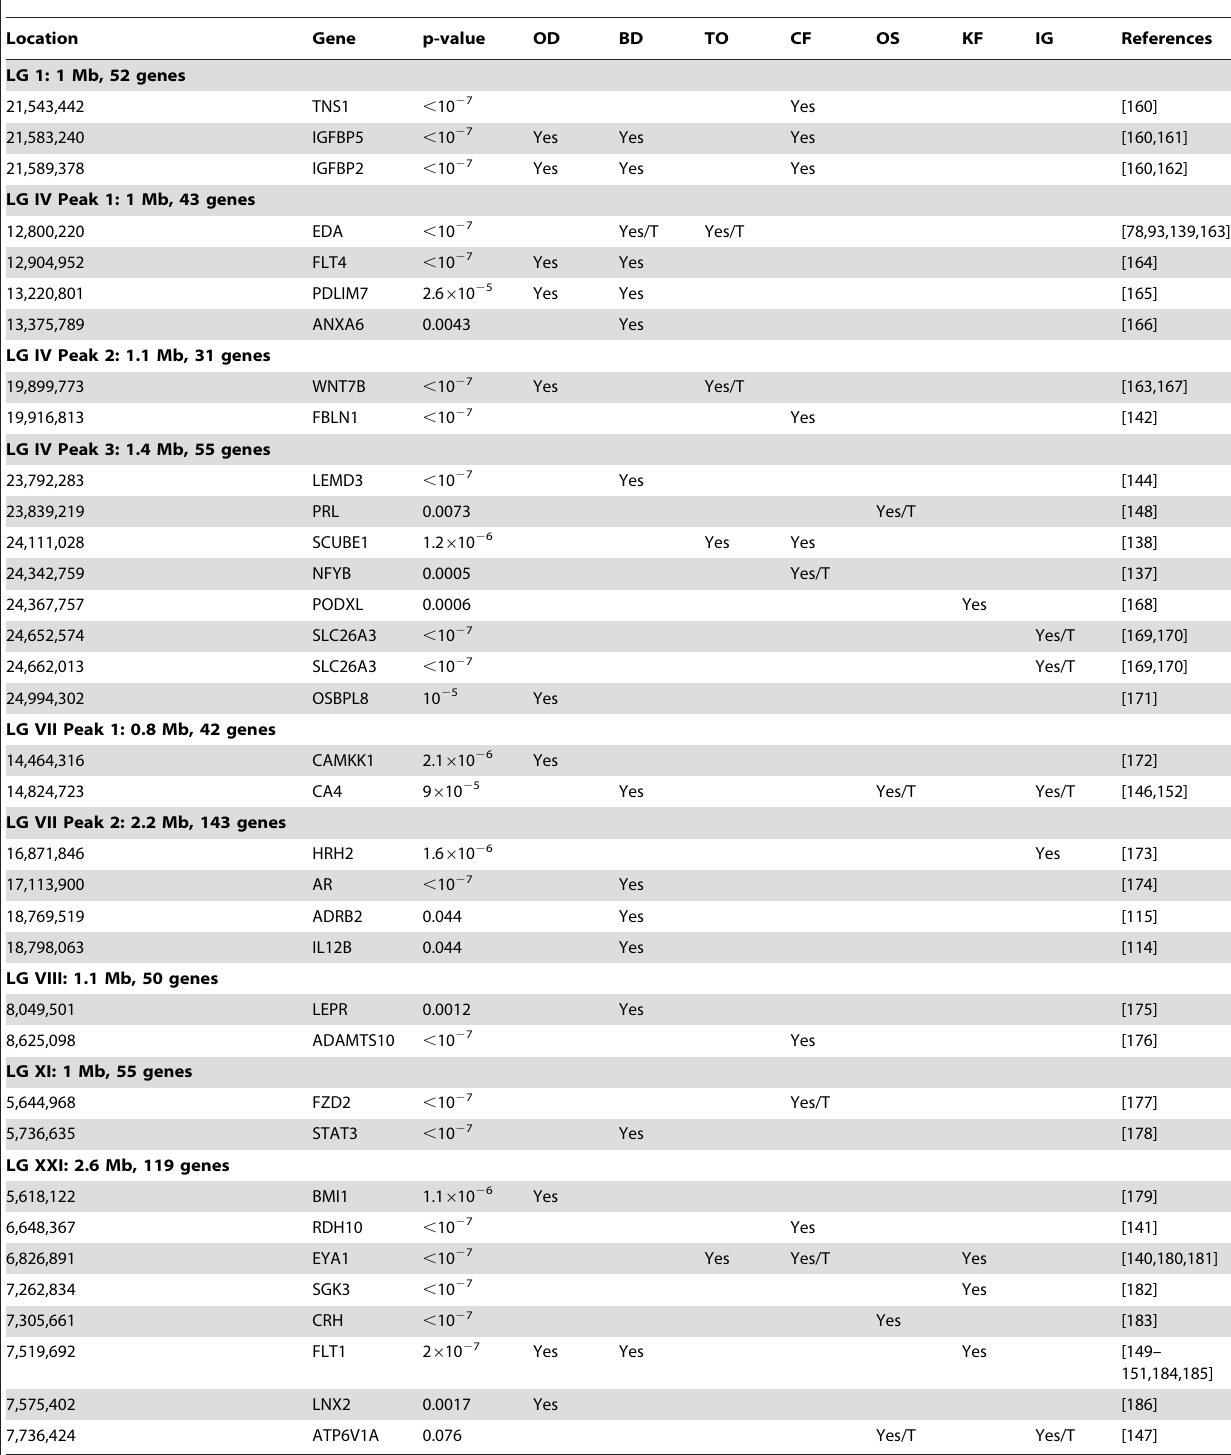
Table 3. Candidate genes related to morphology and osmoregulation, identified within the nine major peaks of parallel differentiation.